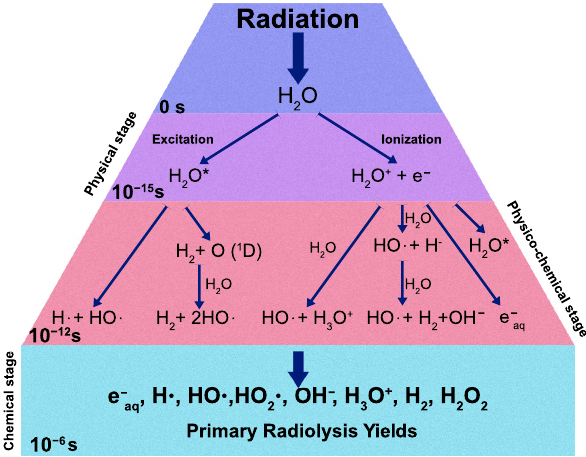
Figure 1. Schematic diagram of water radiolysis